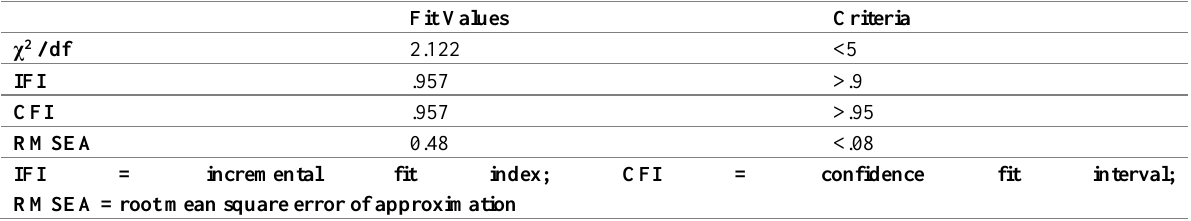
Table 1: Model Fit Indices for Modified